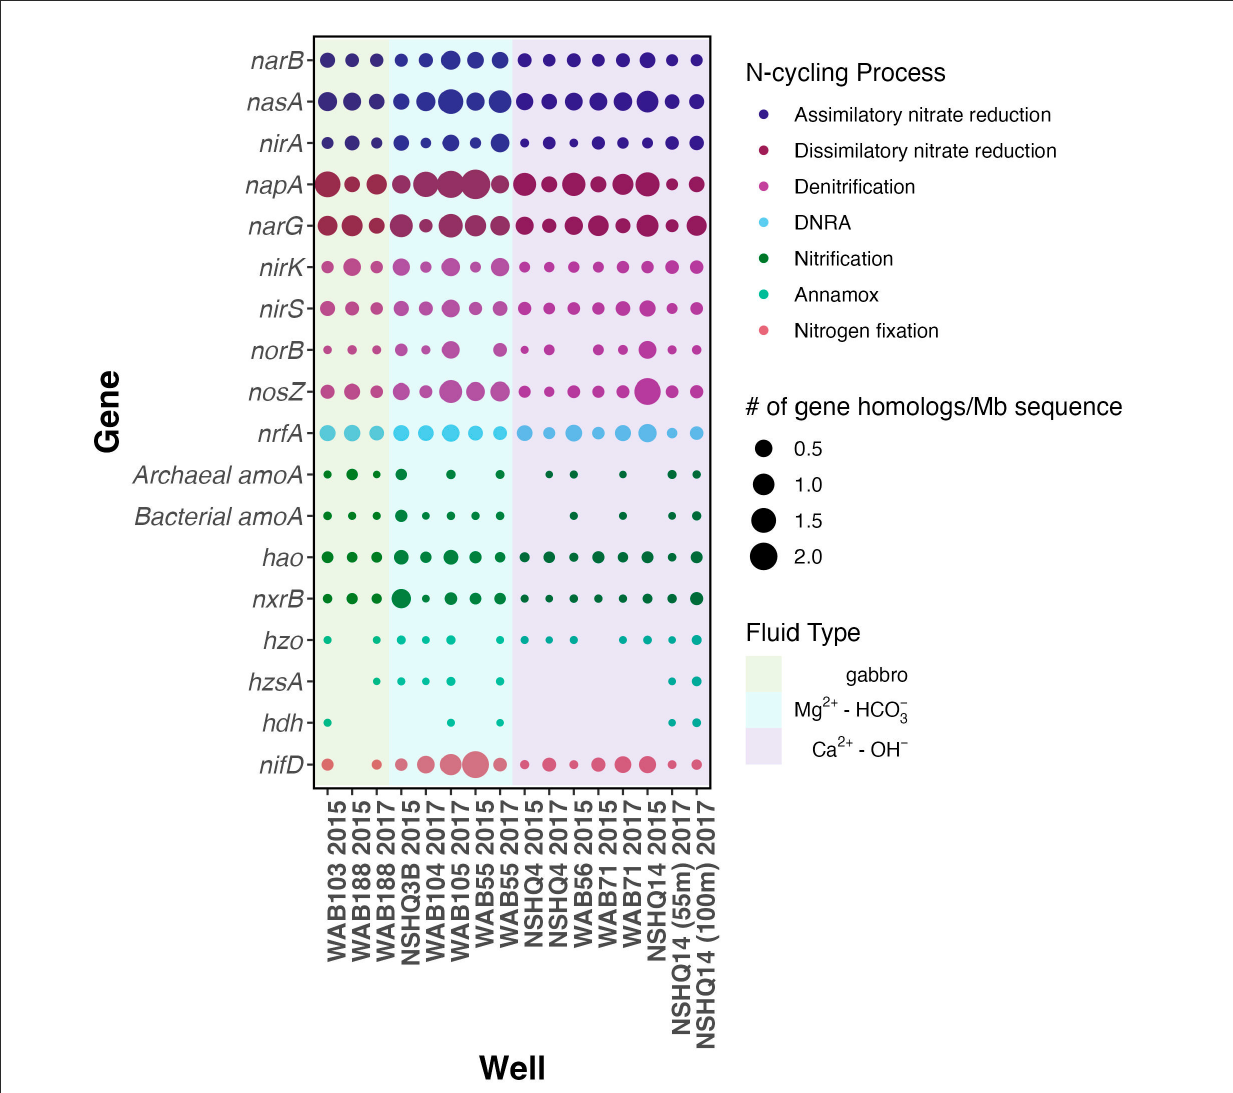
FIGURE5 Dotplot of abundances of key N cycling genes, where the colors of the dots correspond to the type of N-cycling process, the size to the # of gene homologs detected per Mb sequence, and the background color representative of fluid type.